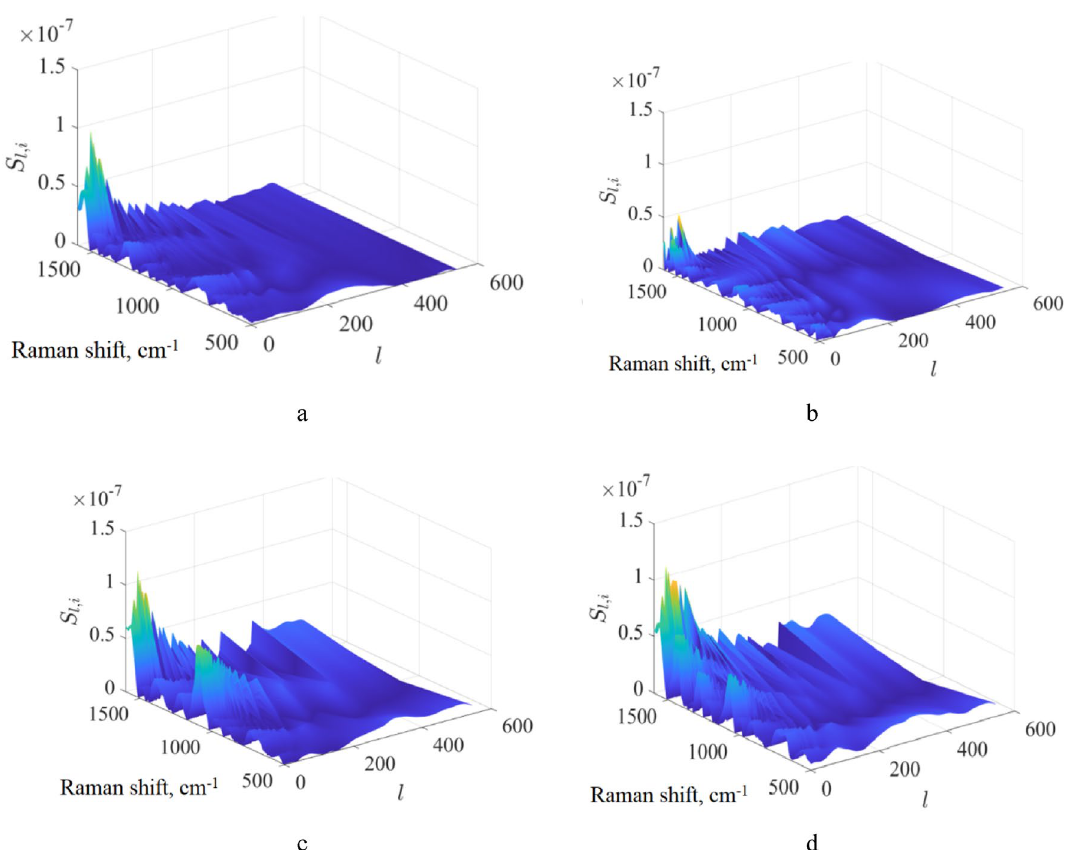
Figure 7. Results of the Soergel distance calculations in an individual sliding spectral window for various Raman bands. The distance is presented in terms of mean values between the Raman spectra of blood on Al foil and pure blue polyester ( a ), denim ( b ), cotton fabric ( c ), and white polyester ( d ) substrates. Here, i is the number of sliding spectral